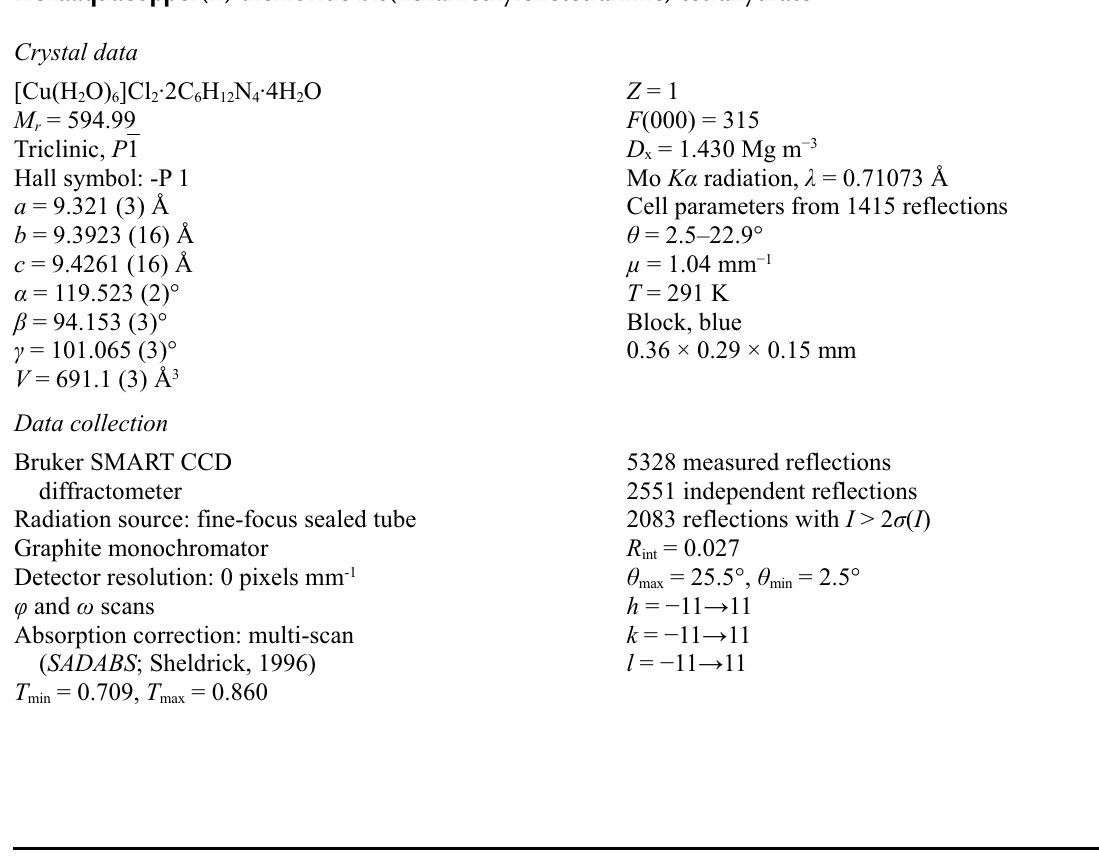
O) ] 2+ cations, chloride anions and 2 6